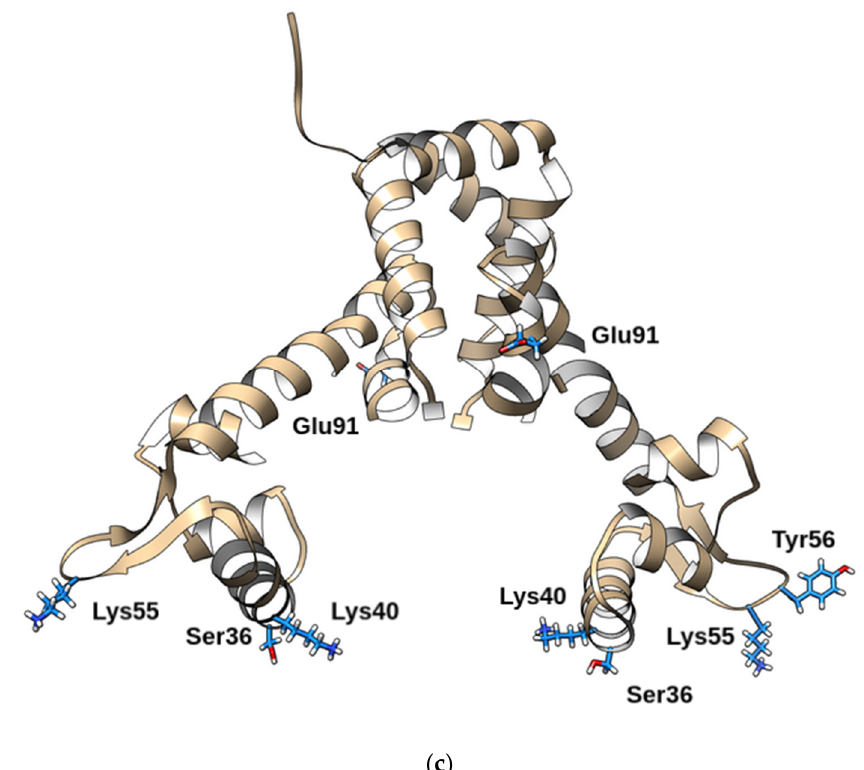
Figure 2. Principal component analysis. ( a ) The projection of four trajectories of the MntR protein in its apo- (red and green) and Mn 2+ -bound forms (blue and purple) onto principal component 1 obtained with principal component analysis of the Cartesian coordinates of the Cα backbone protein atoms. ( b ) Factor loading for principal component 1—the labeled points are counted for each chain of the dimer individually. ( c ) Residues represented in the factor loading for both chains are shown in sticks.